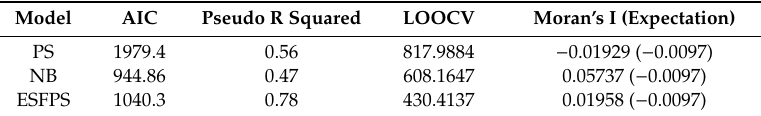
Table 7. Performances of three models.